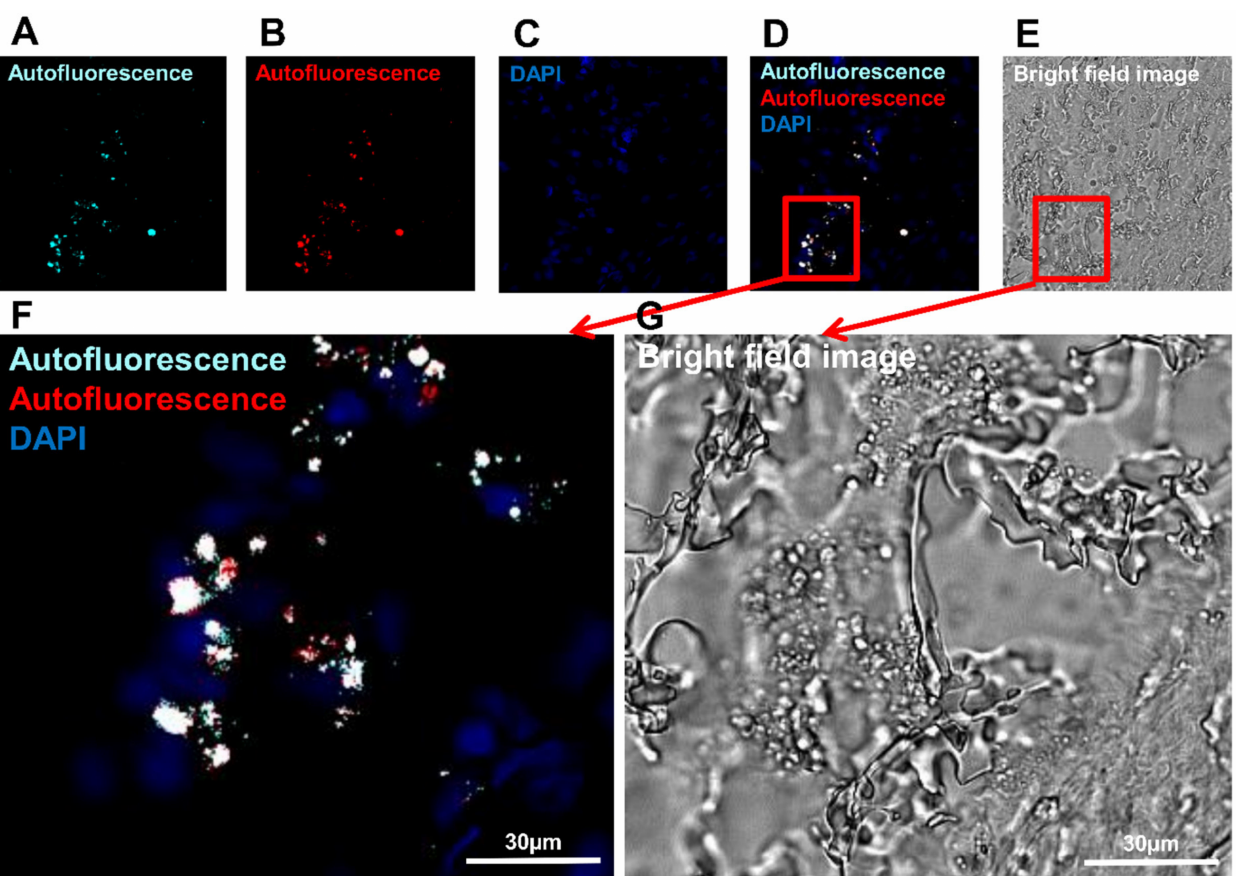
Figure 6. Observation of the autofluorescence in the operated rat femur: ( A ) detected autofluorescence after excitation with light (488 wavelengths, turquoise fluorescence); ( B ) detected autofluorescence after excitation with light (568 wavelengths, red fluorescence); ( C ) nuclear staining with DAPI (blue fluorescence); ( D ) merged image; ( E ) bright-field image; ( F ) expanded view: high magnification image of the area within the red rectangle in image ( D ); ( G ) expanded view: high magnification image of the area within the red rectangle in image ( E